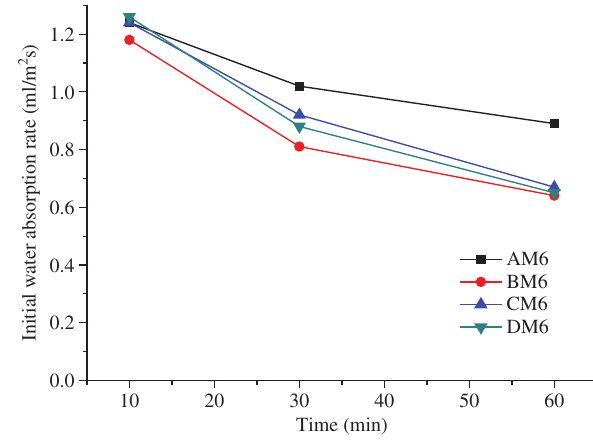
Figure 10: Initial surface absorption of AAFA geopolymer with the alkaline solution/binder ratio of 0.65 vs. time.